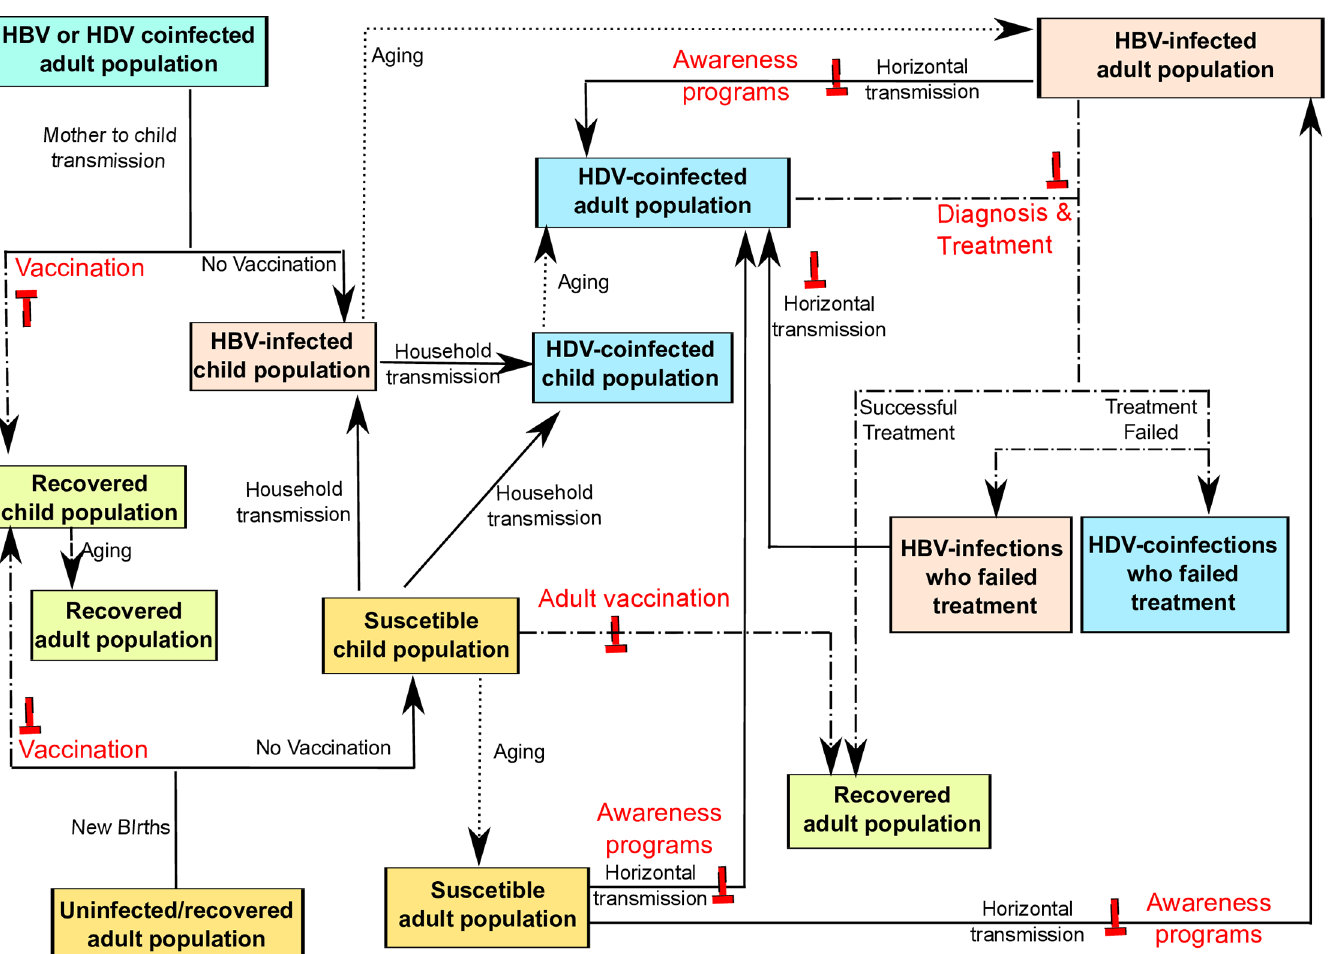
Fig 1. Schematic representation of HBV and HDV transmission in a population along with the interventions employed in the model to counter HBV and HDV epidemics. Green, orange, pink and blue boxes represent recovered, susceptible, HBV mono-infected, and HBV-HDV co-infected groups in the population. Text in red represent one of the five interventions applied: (i) HBV newborn vaccination (ii) HBV diagnosis and adult vaccination, (iii) antiviral treatment for HBV infected individuals, (iv) antiviral treatment for HBV and HDV infected individuals, and (v) awareness programs.